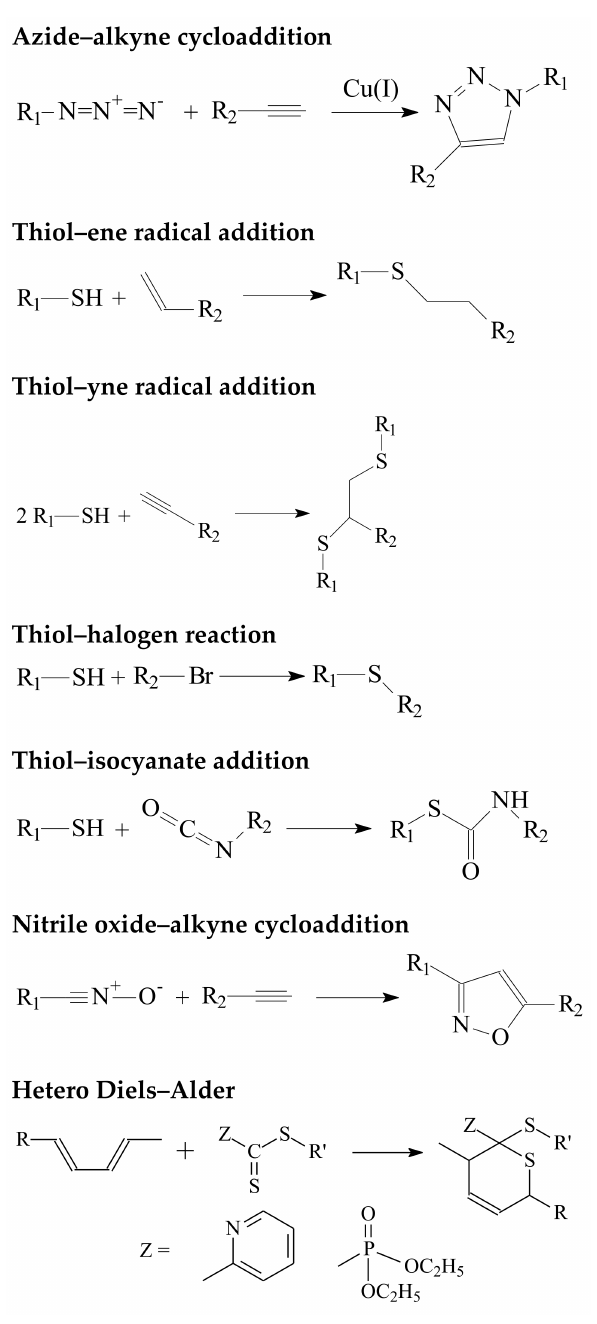
Scheme 1. Examples of click reactions, where R 1 and R 2 are organic